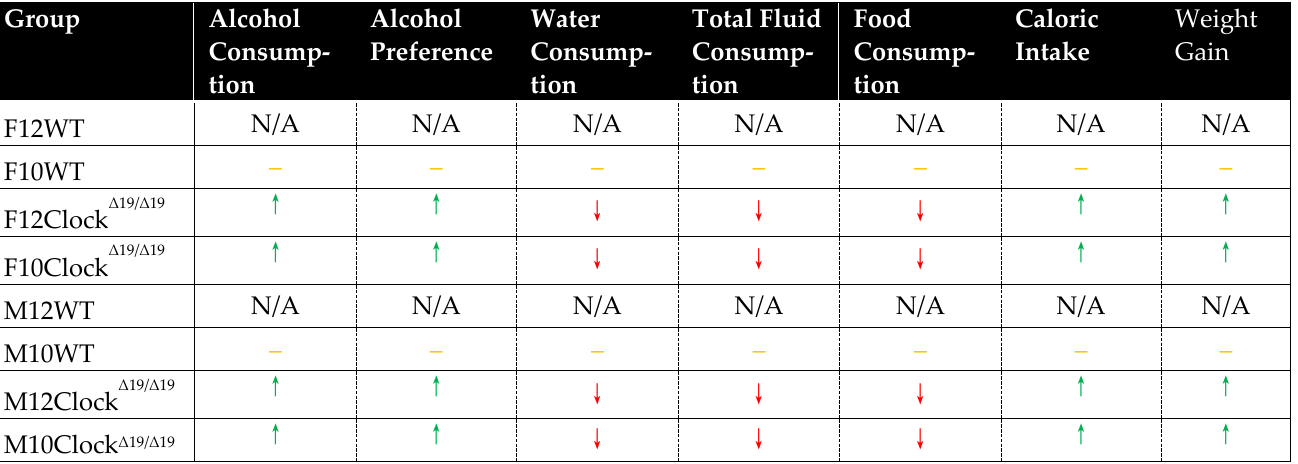
Table 1. A summary table highlighting the reported results across all groups and measures investigated. All female and male values are compared to female or male WT mice on a 12:12 L:D cycle (indicated with “N/A”). F = females, M = males; 12 = 12:12 L:D cycle, 10 = 10:10 L:D cycle; WT = wild-type. Up arrow = increase, down arrow = decrease, horizontal line = no change.